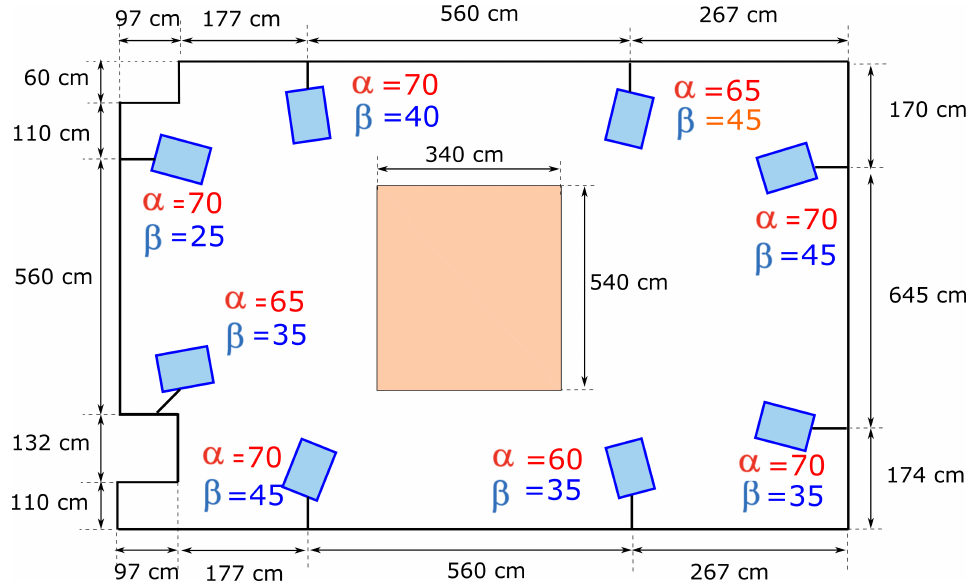
Figure 1. Motion capture cameras arrangement, where α is the angle in the OX plane between the floor and the camera axis, β is the angle in the OY plane between the camera axis perpendicular to the floor and the